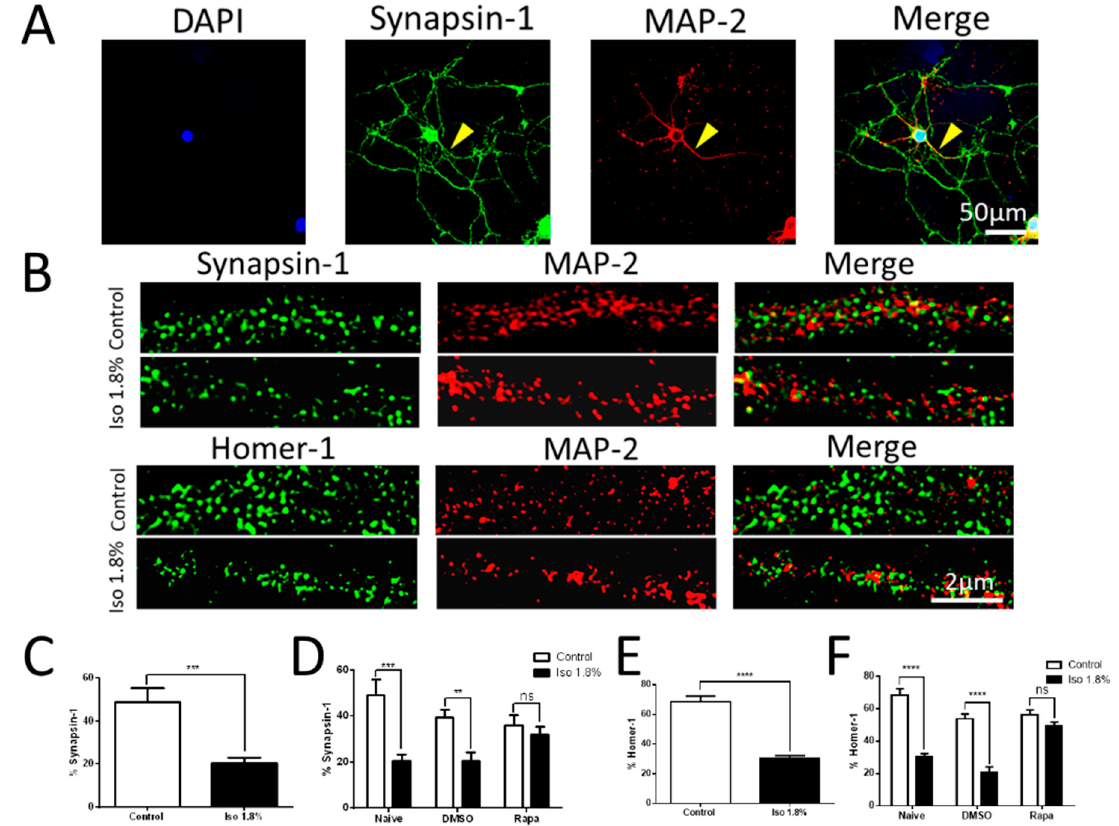
Figure 3. A 1.8% isoflurane exposure for 6 h decreases pre- and post-synaptic marker intensity in vitro. ( A , B ) Representative images of Synapsin-1/Homer-1 (green), MAP-2 (red), DAPI (blue) immunofluorescence in neurons in dissociated culture at 10 DIV are shown. The segment for the dendrite was picked according to MAP-2 staining from each neuron and the locations for images taken were defined as 20–30 μ m from the nucleus according to DAPI (shown as the yellow arrow pointing in ( A ); ( C – F ) 6 h of isoflurane exposure on 7 DIV caused a significant difference in the intensity decrease of Synapsin-1 compared to the control group ( C ), while rapamycin treatment before the isoflurane exposure reversed the Synapsin-1 intensity to normal compared to the control with rapamycin treatment group ( D ). The intensity of Homer-1 also decreased compared to the control group ( E ), while rapamycin treatment before the isoflurane exposure reversed the Homer-1 intensity to normal compared to the control with rapamycin treatment group ( F ). ( n = 30 neurons measured per group, ** p < 0.01, *** p < 0.001, **** p < 0.0001, n.s. indicates no significant difference, t -test for ( C , E) , two-way ANOVA with Bonferroni’s multiple comparisons test for ( D , F ).